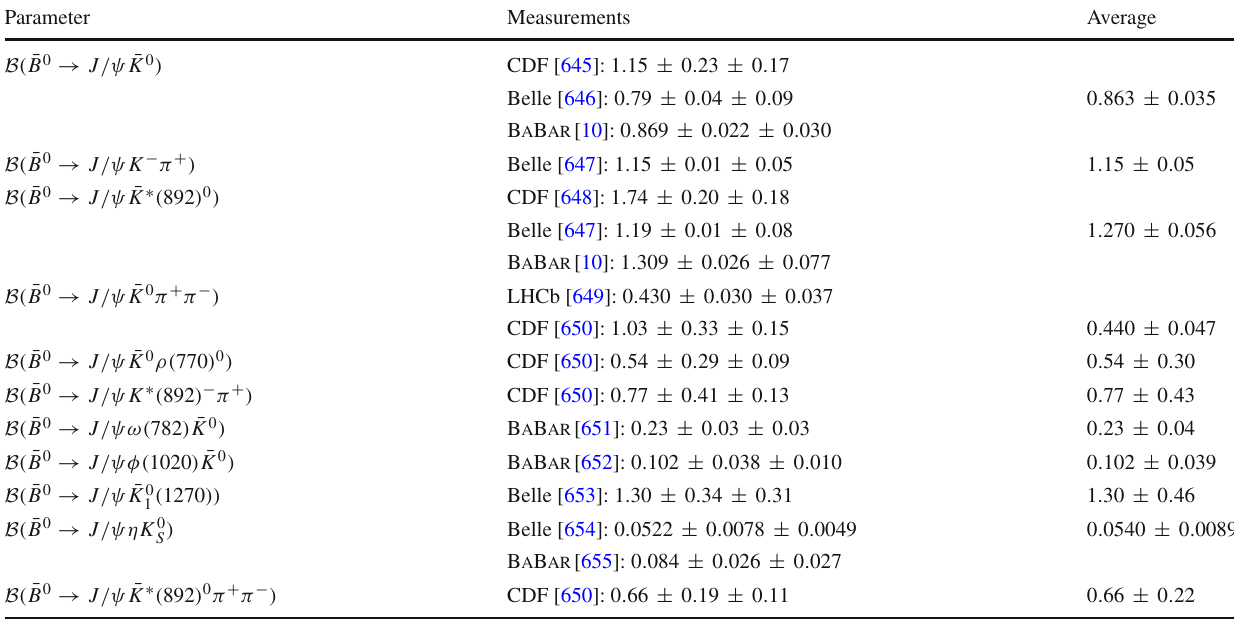
Table 116 Decays to J /ψ and one kaon [ 10 − 3 ] Parameter